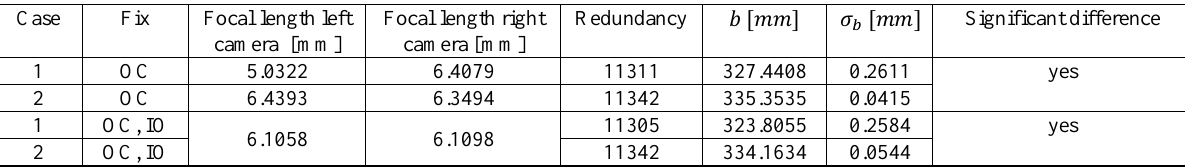
Table 2. Results of bundle adjustment. Column 2: Fixed parameters, which are not adjusted during bundle adjustment. (IO = Interior Orientation, OC = object coordinates) Colum 3 and 4: Focal length. Column 5: Redundancy. Columns 6 and 7: Base length and standard deviation. Column 8: Result of test for significant